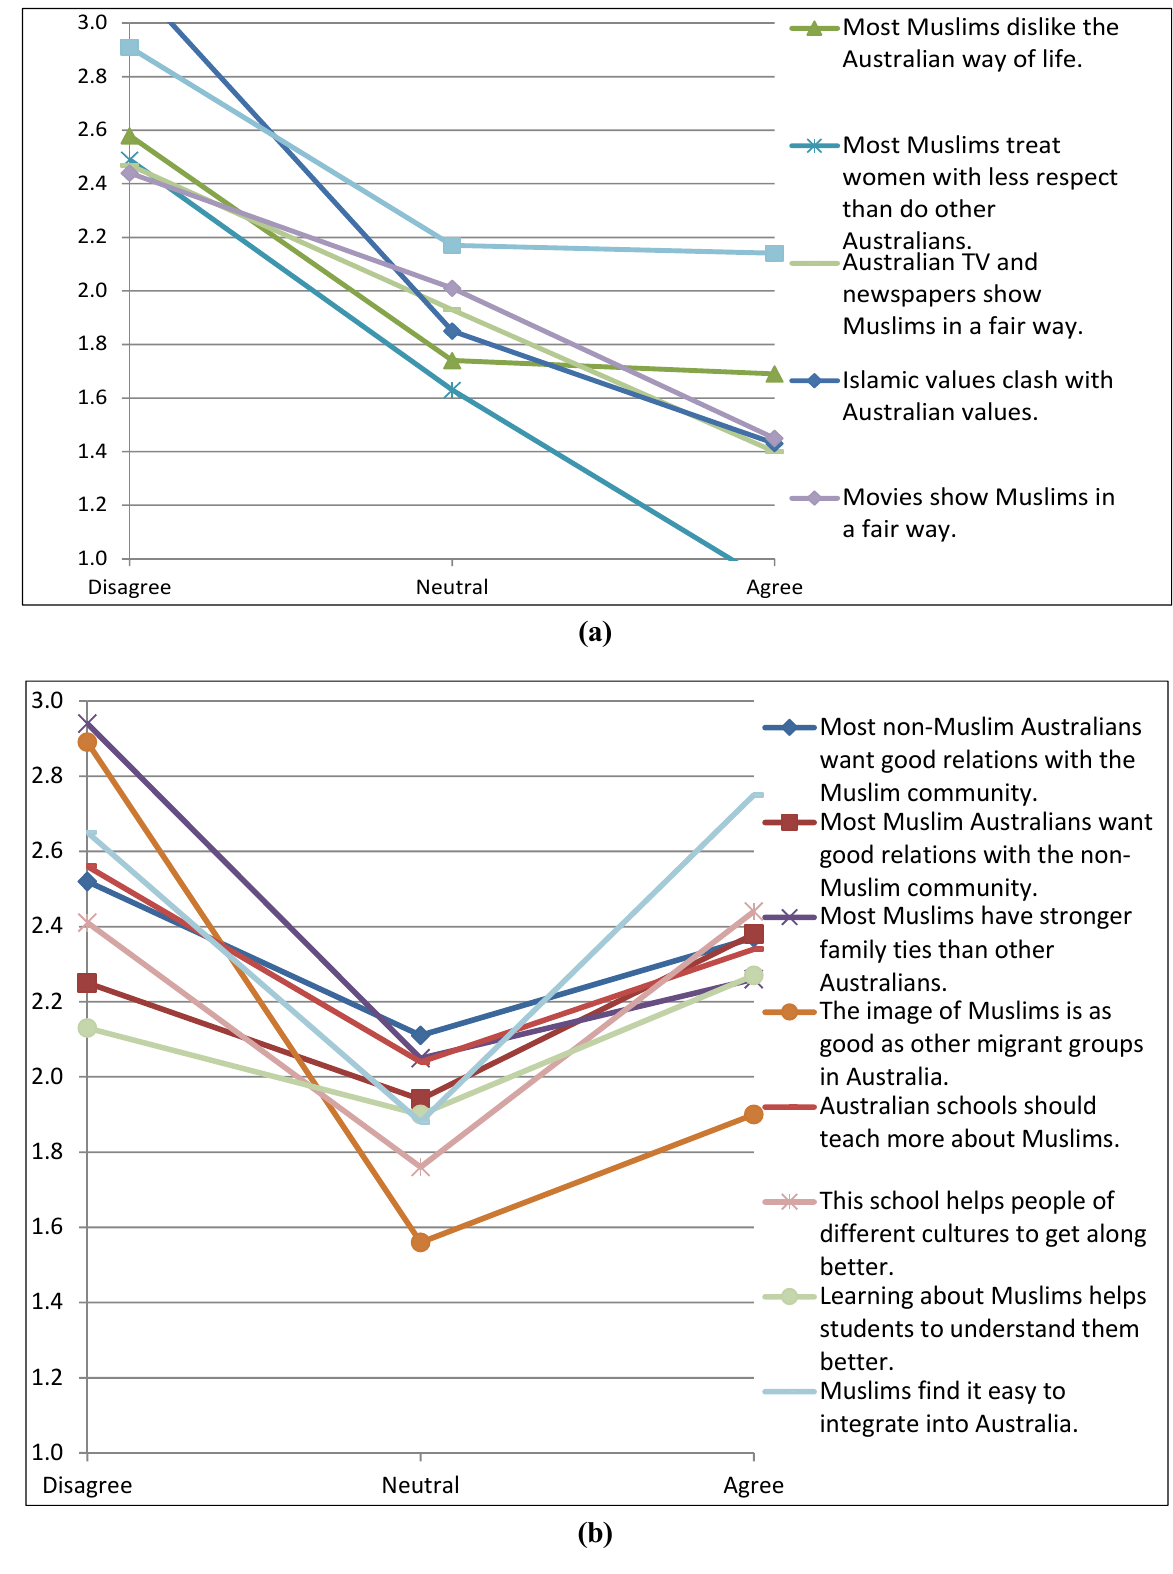
Figure 2. Tabulation of two variables showing Level of Knowledge and responses of positive attitudes. (a) Statements largely relate to the mass media, clash of values and women; (b) Statements largely relate to schools and relationship with other